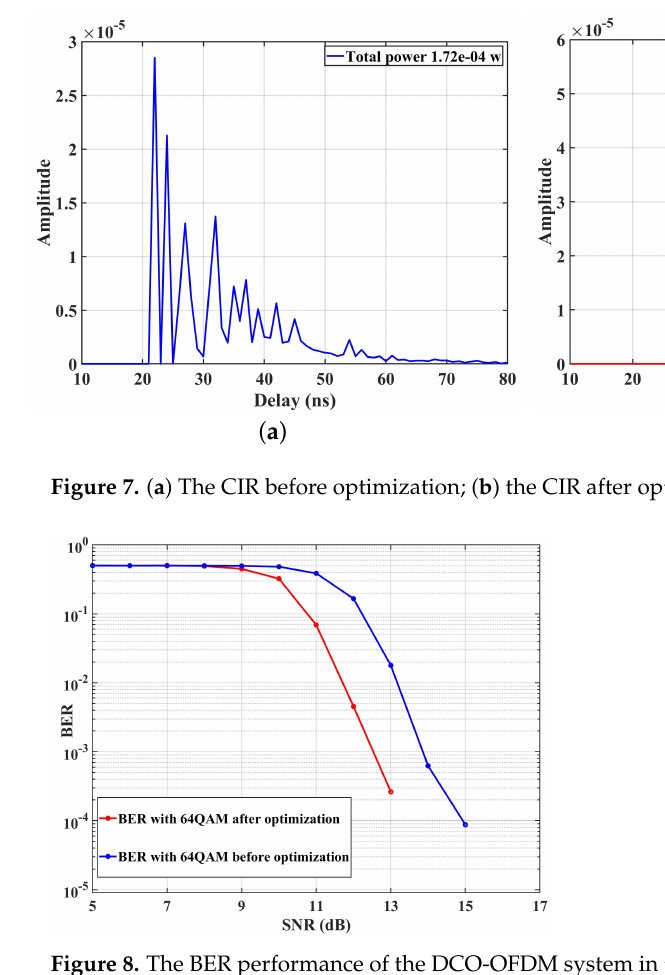
Figure 6. ( a ) Comparison of RMS DS before and after optimization; ( b ) comparison of SNR before and after optimization.